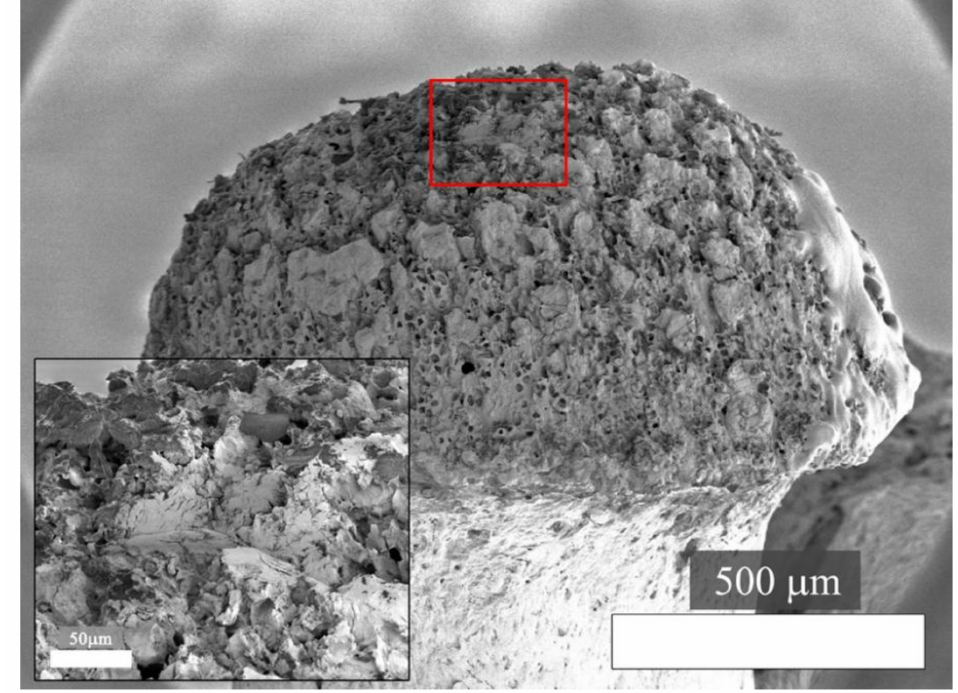
Figure 6. Secondary electron SEM image of the indentation residual imprint location on the femoral head and higher-magnification of the indentation (inset) at 1 kV with a tilt angle of 45 ◦ .